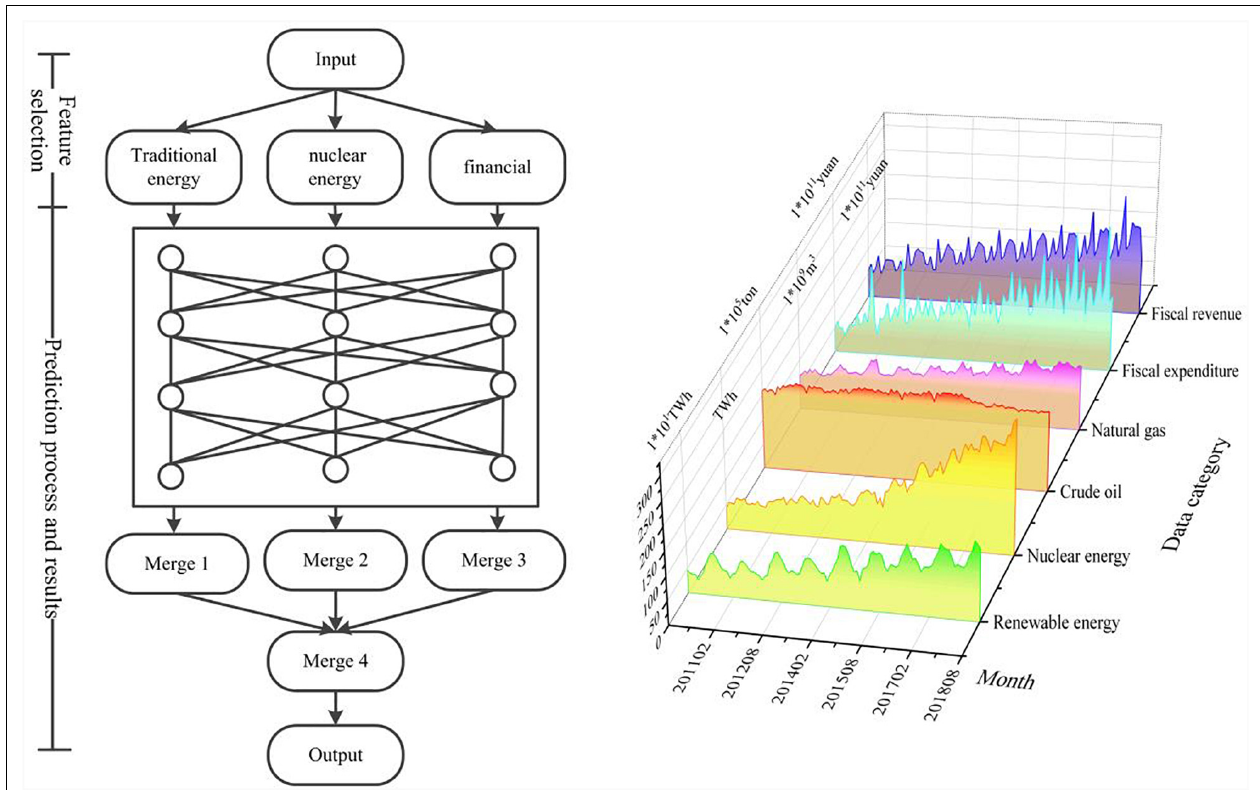
FIGURE 2 | Model structure and historical data analysis.